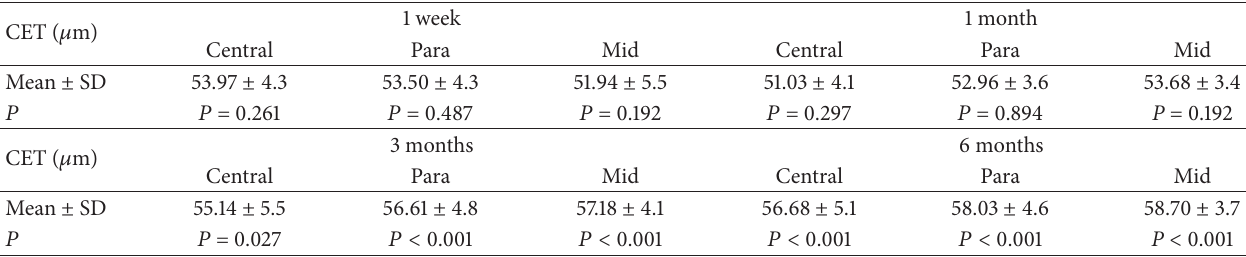
Table 1: Epithelial thickness profile at 1 week, 1 month, 3 months, and 6 months after T-PRK.